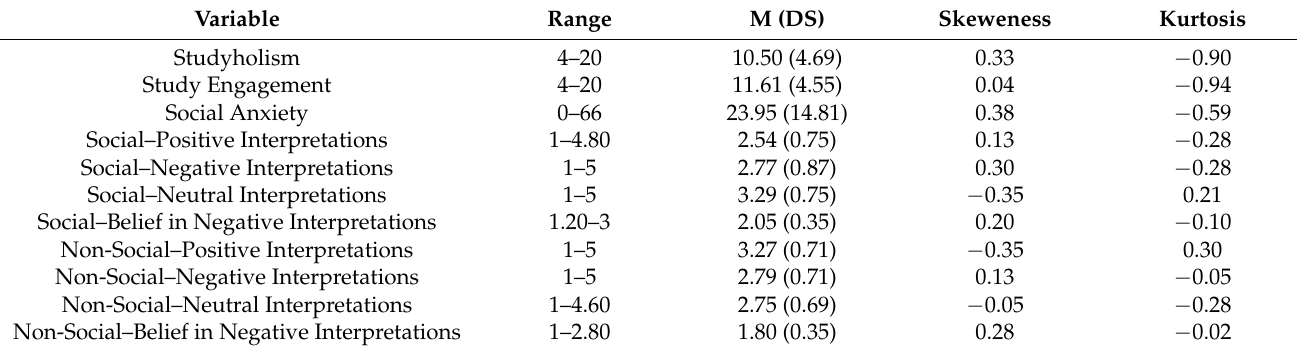
Table 1. Descriptive statistics of the variables in the model ( n = 541).